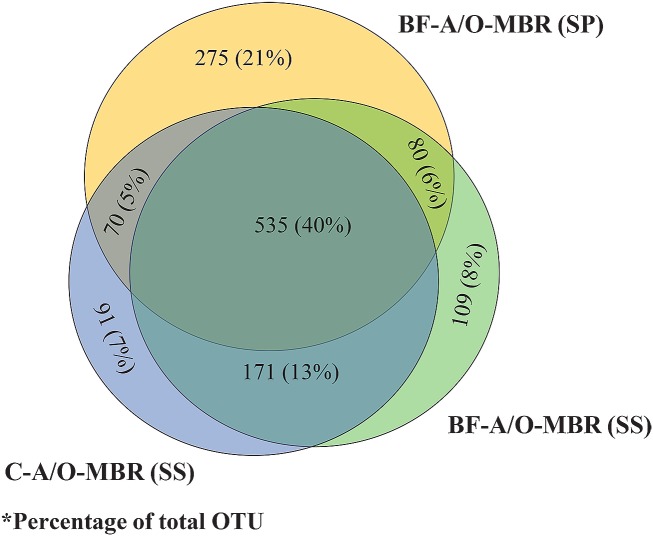
Venn’s diagram of exclusive and shared OTU between sponge biomass sample of BF-A/O-MBR system (BF-A/O-MBR (SP)) and suspended sludge samples of both BF-A/O-MBR and C-A/O-MBR system (BF-A/O-MBR (SS) and C-A/O-MBR (SS), respectively).